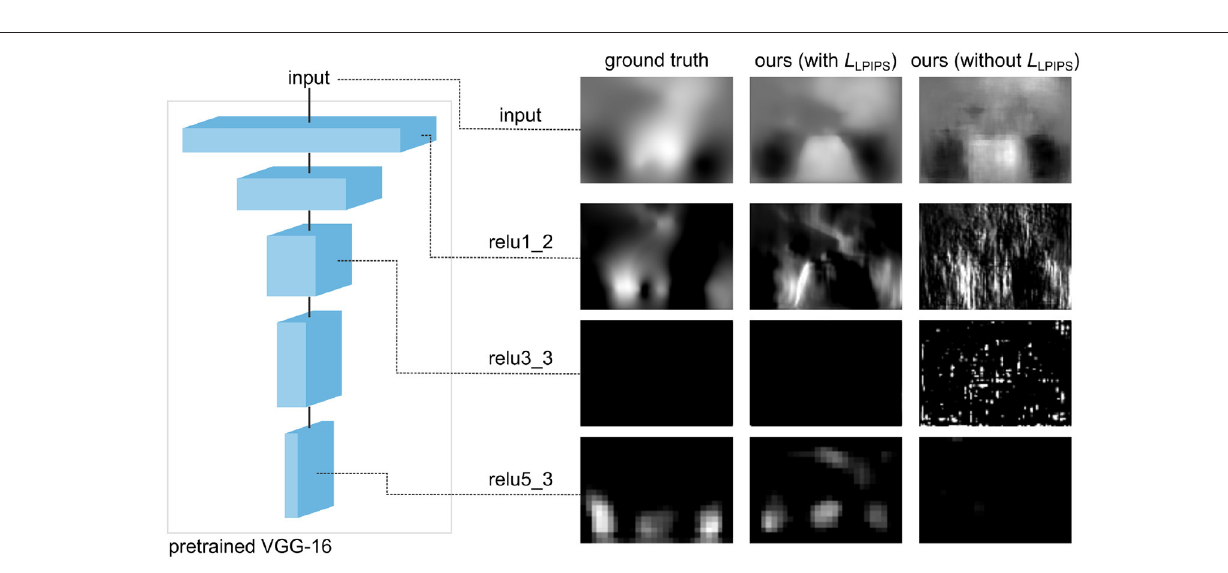
FIGURE 6 | Activations of the pre-trained network used to compute L LPIPS on the y component of the transformation u for the coronal section 352 of SST gene (same as in Figure 5 ). The deep features of the non-smooth predicted ˆ u obtained by training without L LPIPS significantly differ from those of smooth transformations corresponding to the ground truth u and predicted ˆ u obtained by training with L LPIPS